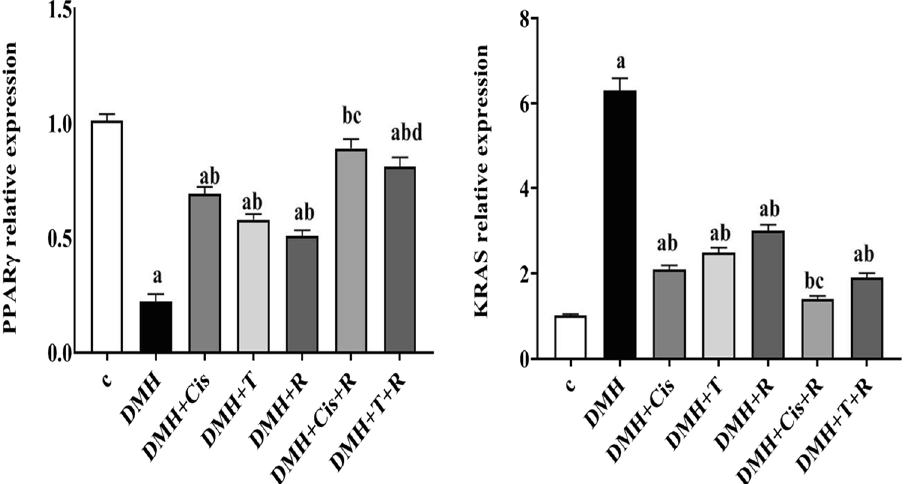
Fig. 5 Effect of concomitant treatment with thiophene derivative and low dose γ-irradiation on PPARγ and KRAS expression. C: control, DMH: dimethyl hydrazine, Cis: cisplatin, T: thiophene deriva- tive, R: radiation. Values are the mean ± SEM (n = 6). a Sig- nificant change compared to the control group. b Significant change compared to DMH group. C Significant change compared to DMH + Cis. d Significant change compared to DMH +